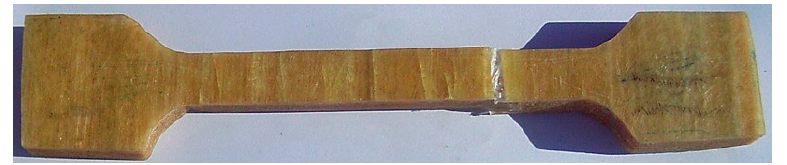
Figure 9. Tensile specimen fracture mode.